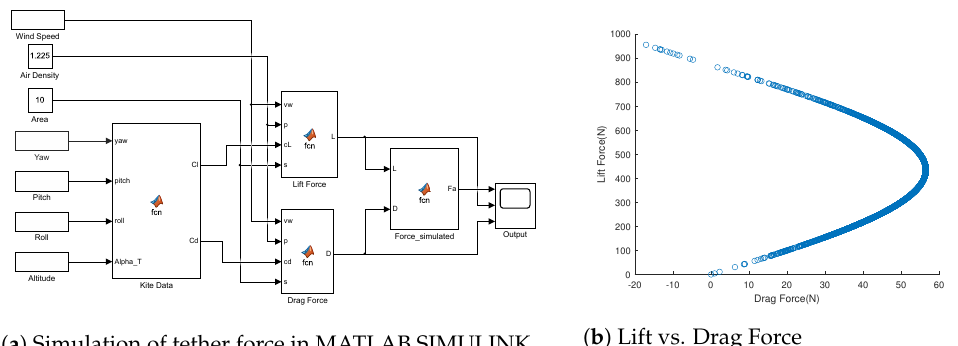
Figure 12. Simulation of tether force in MATLAB SIMULINK: ( a ) From left, the data from the field test are given as a numeric matrix and the kite’s data block filters the data to calculate the lift and drag forces; the force–simulated block calculates the tether force. ( b ) Shows a plot of the lift force vs. drag force from the simulated tether force.